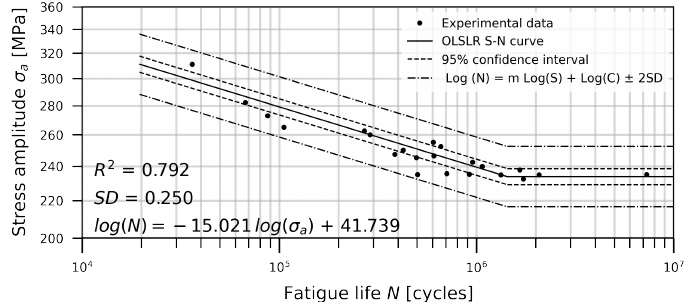
Figure 5. S-N curve obtained from the rotating bending experiments ( R = − 1) for the specimens extracted from the transverse direction.